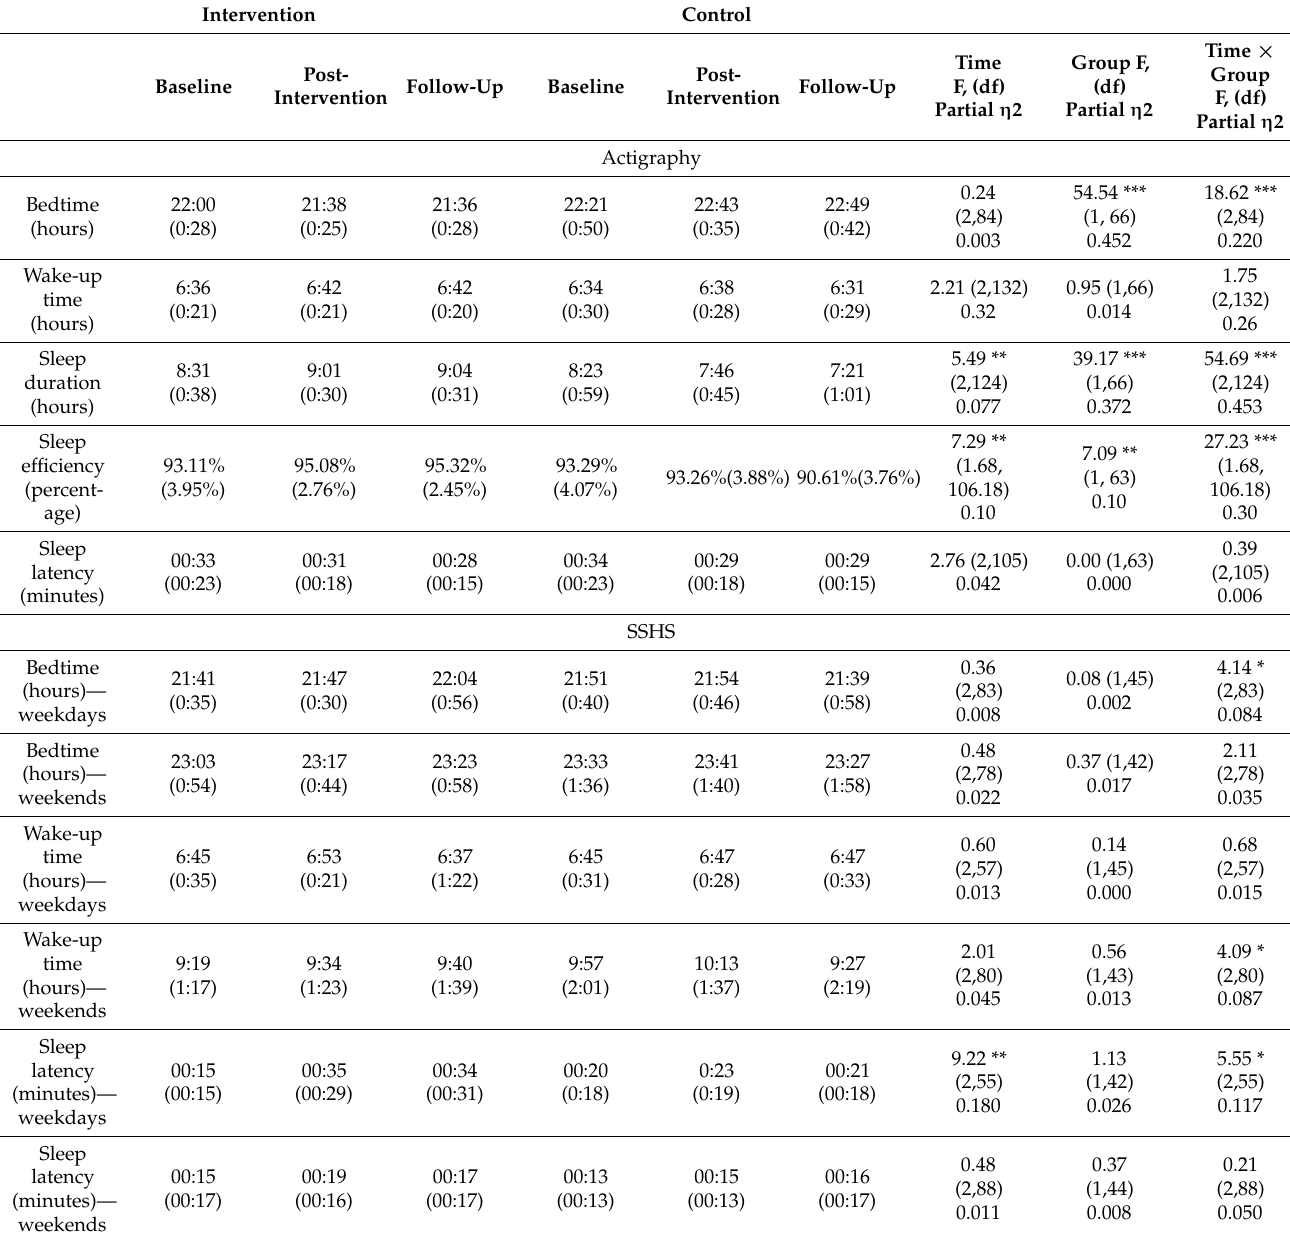
Table 1. Means (SD/df) and partial η 2 of sleep measures (actigraphy and adolescent reports-SSHS) at baseline, post-intervention and 3 month follow-up, by time, group, and time*group